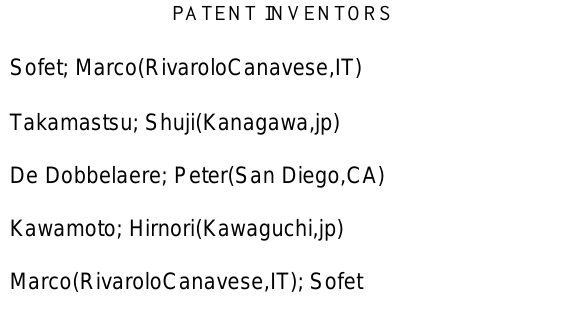
Table 1. Dataset from patent database